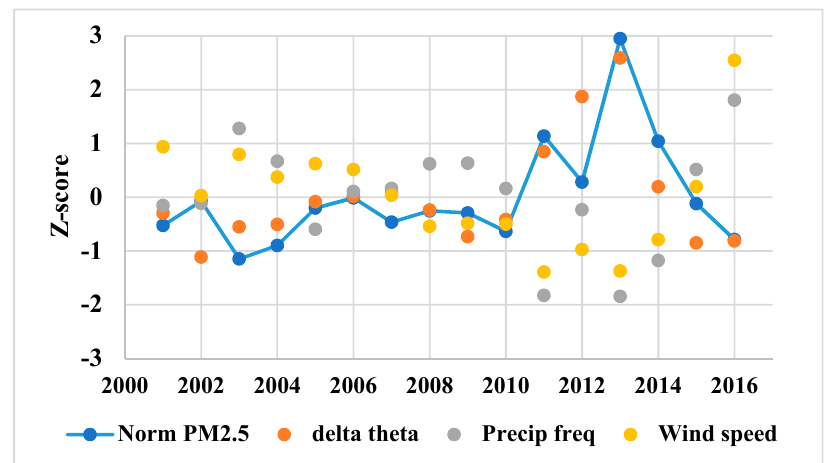
Figure 11. Z-score for winter average emissions-normalized PM 2.5 , Trimmer–Garland potential